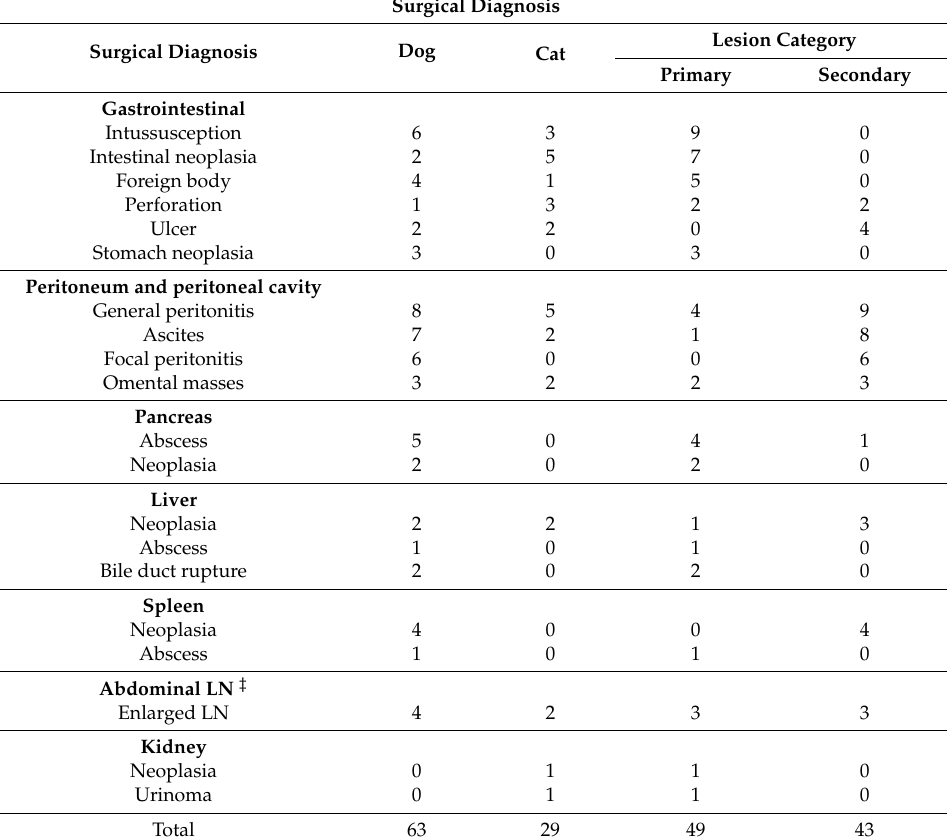
Table 1. Distribution of intraoperative lesions according to anatomical location.